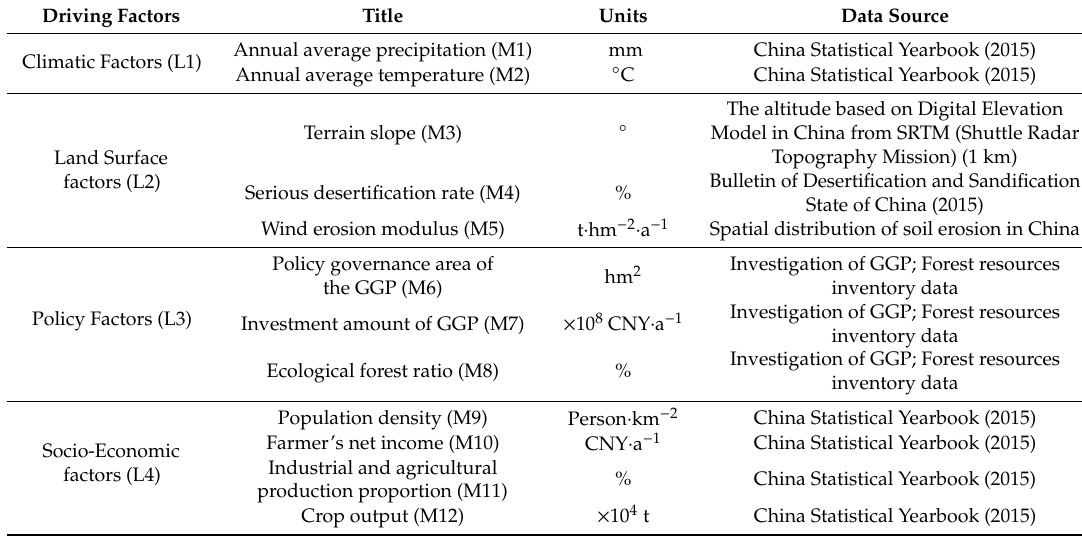
Table 4. Driving factors on the variation of sand fixation (Y1) and dust retention (Y2) for Grain for Green project based on Structural Equation